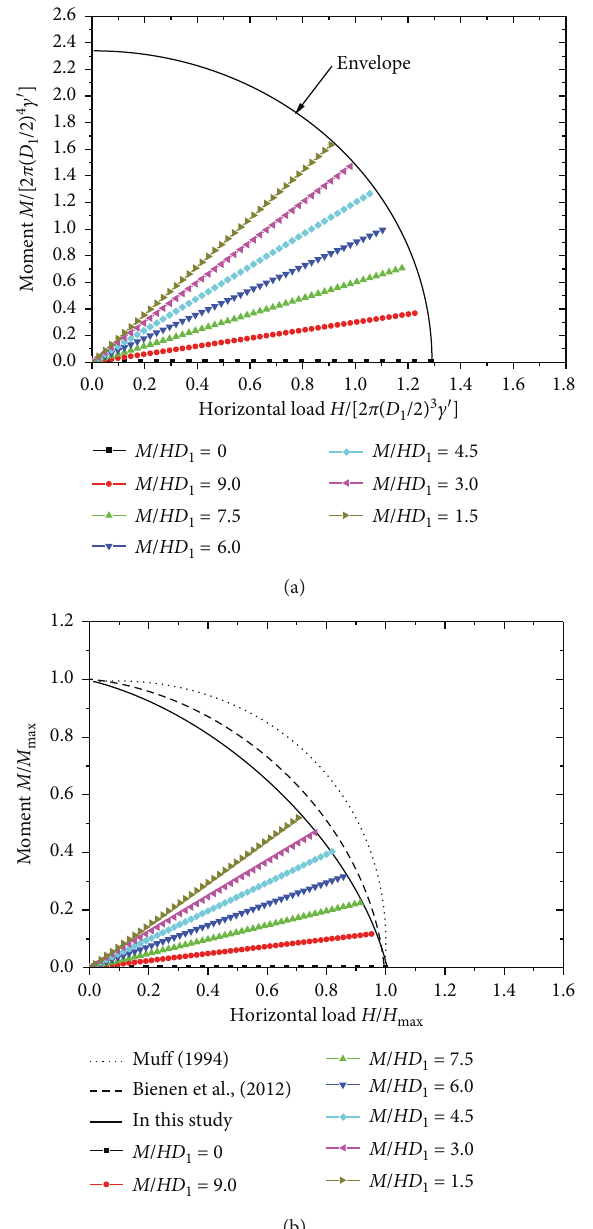
Figure 16: Failure envelope in H - M at V shaped foundation. (a) H - M failure envelope. (b) Normalized form.